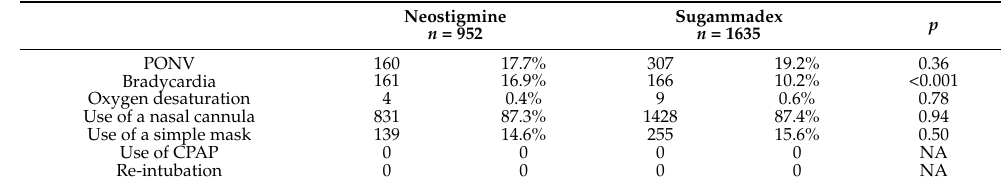
Table 4. Adverse events in the PACU (original